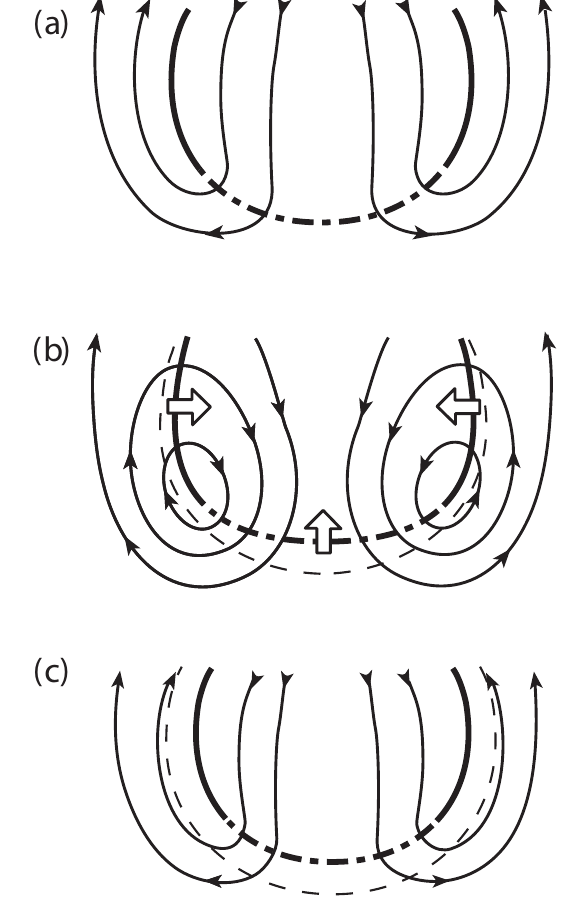
Fig. 10. Sketch showing idealized boundary motions and plasma streamlines (a) before, (b) during, and (c) after the substorm stud- ied here, such that (a) and (c) correspond to quasi-steady states, while (b) corresponds to an interval in which the tail reconnection rate is enhanced and exceeds the dayside rate. The heavy lines show the position of the open-closed field line boundary, which is shown solid in the adiarioc portions and dot-dashed in the region of the nightside merging gap. The large arrows in (b) show the motion of the boundary after the enhancement of tail reconnection rate has taken place, while the dotted line in (b) and (c) shows the initial po- sition of this boundary for ease of comparison. The lighter arrowed lines show the plasma